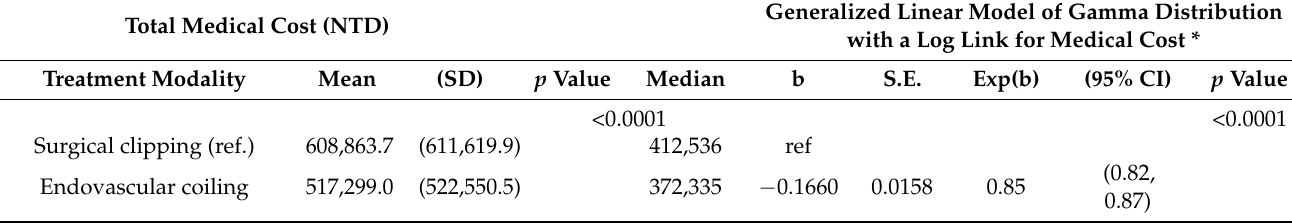
Table 4. Total medical cost of index hospitalization stratified by aneurysm repair modalities in propensity score–matched patients with ruptured cerebral aneurysms who received surgical clipping or endovascular coiling. Generalized Linear Model of Gamma Total Medical Cost (NTD)